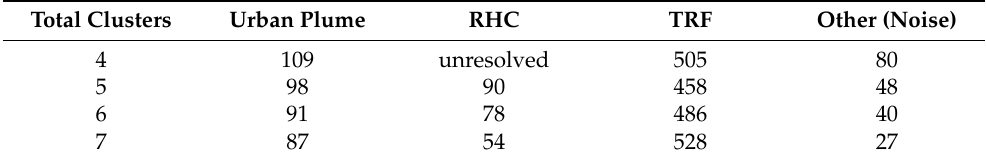
Table 3. Mean source contributions to BC ff (ng/m 3 ) for a different choice of total clusters sought. Total Clusters